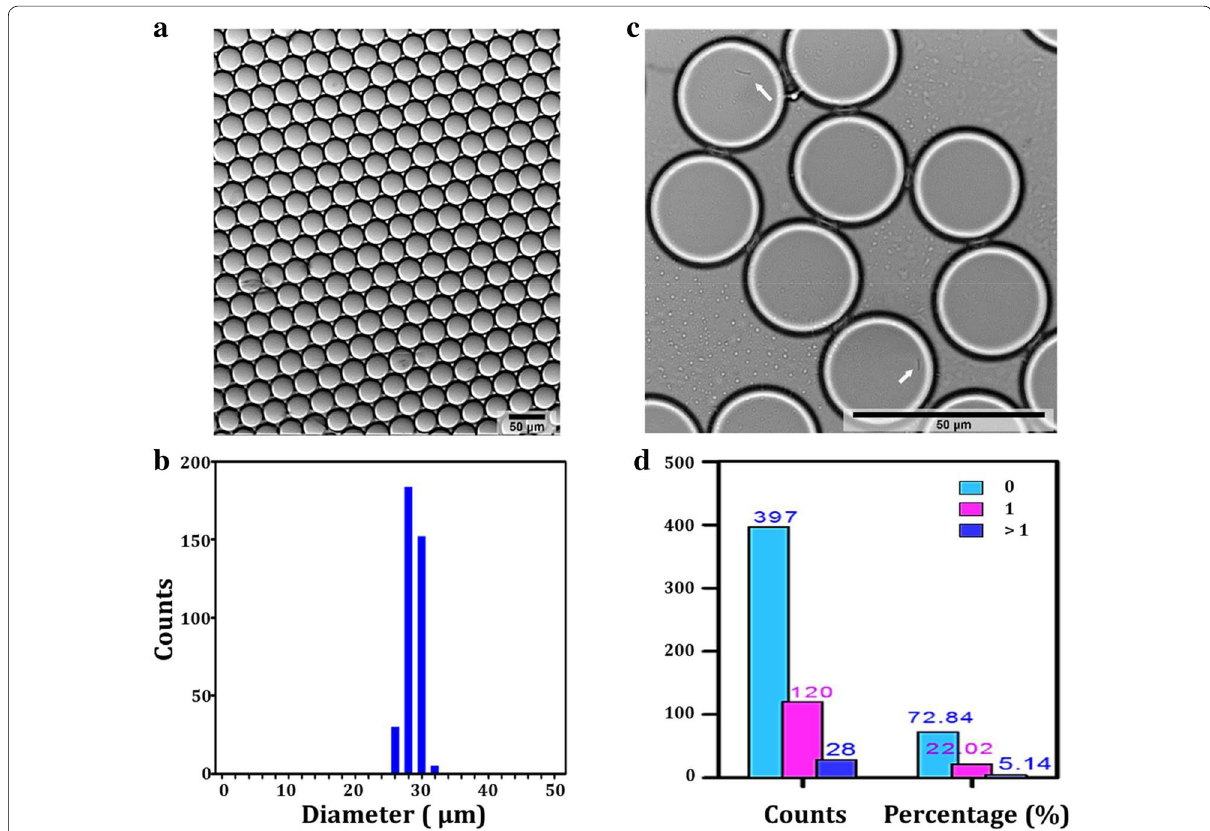
Fig. 2 Generation of W/O (water in oil) microdroplets by a microfluidic droplet generator. a Microphotograph of microdroplets generated by a microfluidic droplet generator. Scale bar: 50 μm. b Distribution of the microdroplet diameters. The overall variation coefficient is 3.69%. c A bright-field microscopy image showing B. coagulans (highlighted by white arrows) being encapsulated in microdroplets. Scale bar: 50 μm. d Initial number of cells per droplet. More than 500 droplets were investigated immediately after generation. The number and percentage of droplets containing 0, 1 and more than 1 cells are